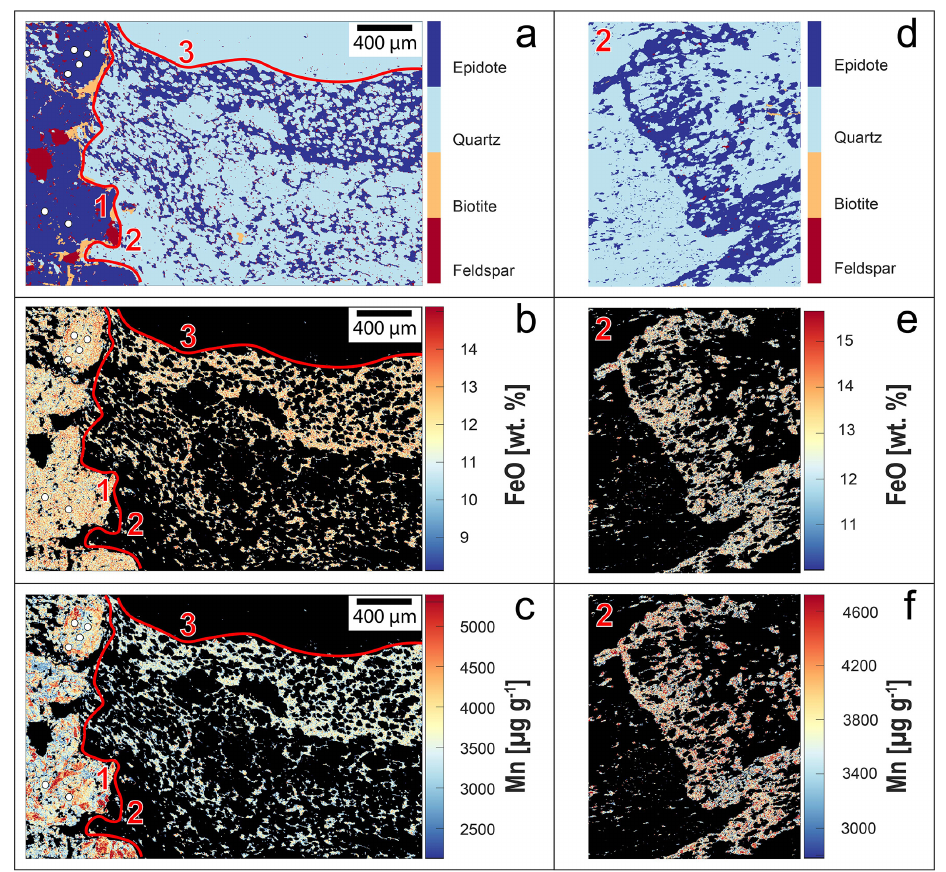
Figure 10. (a–c) Compositional maps across layers 1–3; white circles indicate spots for U–Pb dating by LA-ICP-MS of Peverelli et al. (2021). (d–f) Compositional maps of layer 2. For locations, see Fig. 3. Red numbers indicate vein layers, which are separated by the red curves. Scale bars in (a–c) also apply to (d–f) .